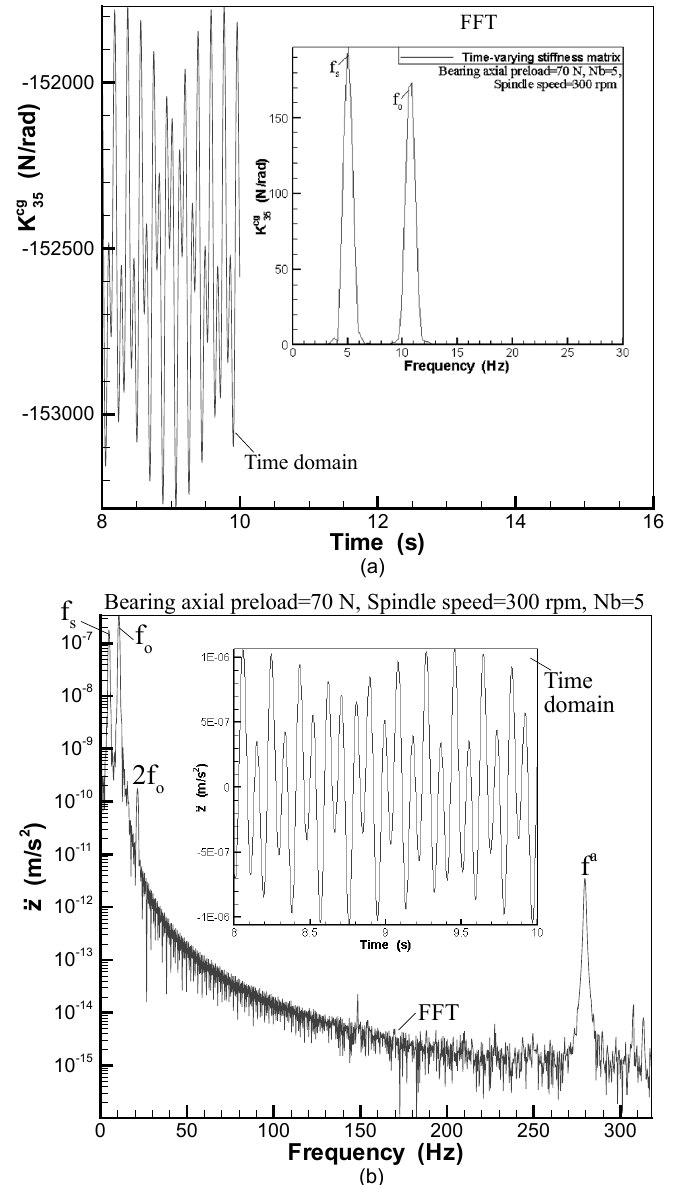
Fig. 12. Time domain and FFT of K cg 35 [Fig. 12(a)]; Time domain and FFT of the mass center axial vibration [Fig. 12(b)]. Time varying stiffness matrix is used. Ω s = 300 rpm. Mass eccentricity μ a = μ b = 18 μm . Spindle is subject to a force F cut = 50 N in the horizontal direction at its cutting nose. Nb = 5. Bearing axial preload = 70